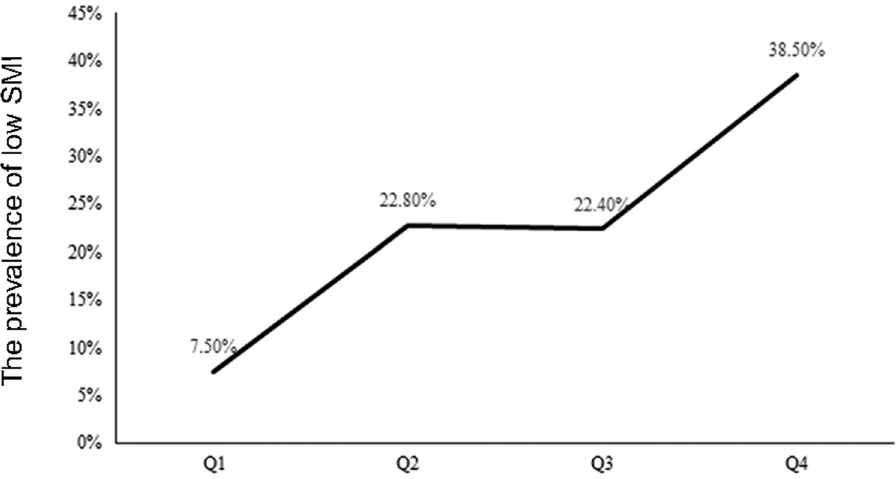
Figure 1: Prevalence of low SMI across the quartiles of serum β - CTX. The quartiles of serum β - CTX: Q 1: ≦ 0.220 ng/mL, Q 2: 0.221 – 0.310 ng/mL, Q 3: 0.311 – 0.480 ng/mL, and Q 4: > 0.480